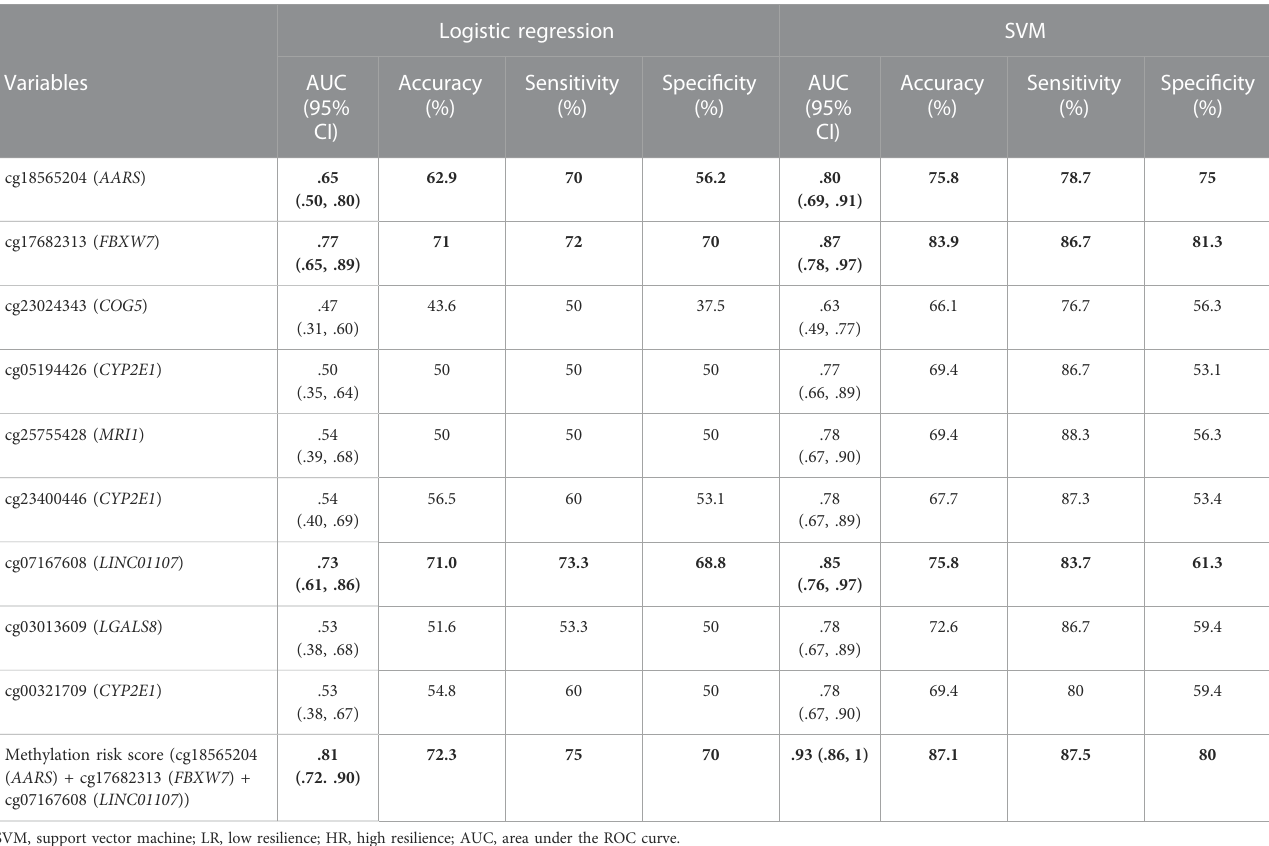
TABLE 3 Logistic regression and SVM models of methylation probes and methylation risk scores for LR and HR groups in the validation set.